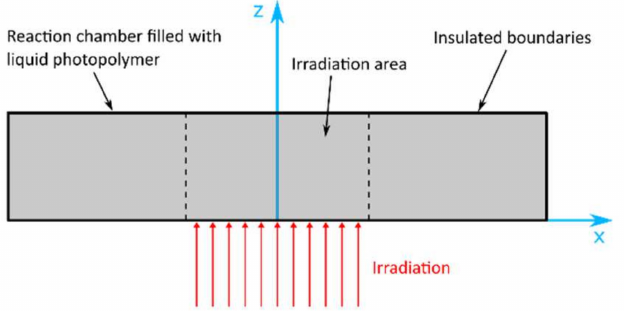
Figure 30. Reaction chamber modeled in COMSOL for the photopolymerization simulation of ECPL (Exposure Controlled Projection Lithography). Redrawn from reference